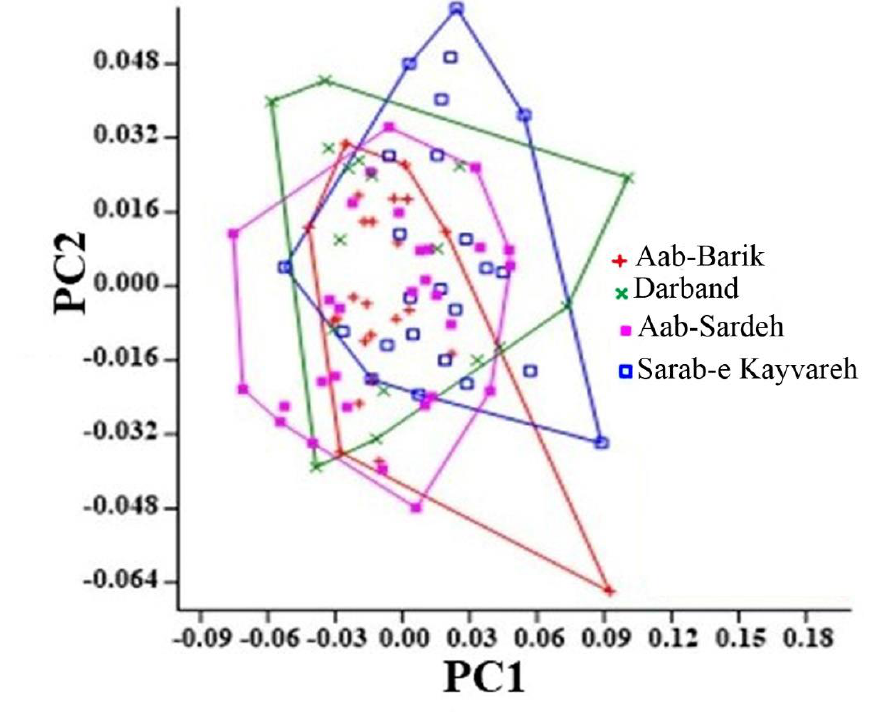
F IGURE 2. Principal Component Analysis (PCA) of A. idignensis populations in Tigris River.